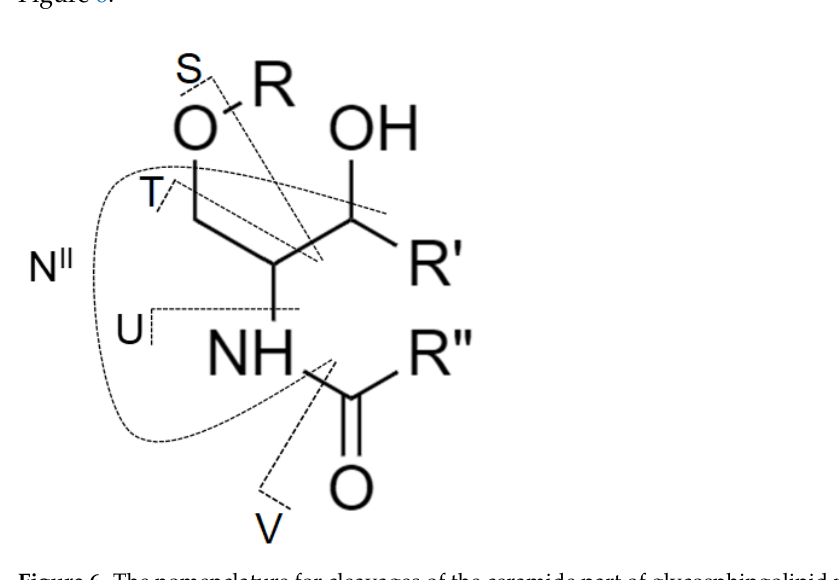
Figure 6. The nomenclature for cleavages of the ceramide part of glycosphingolipid molecule used in this work and originally proposed by Ann and Adams [51] with the addition from Merrill et al. [9].